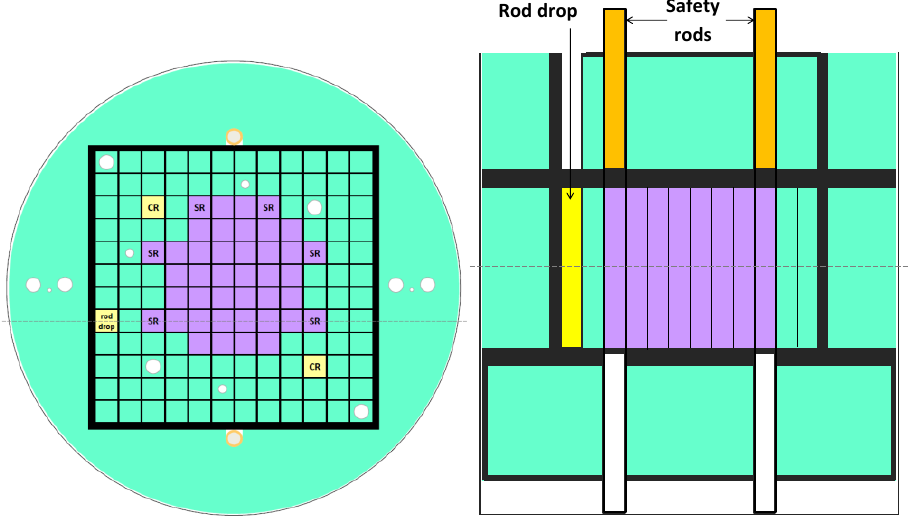
Fig. 2. Left: radial cut through the VENUS-F reactor configuration discussed in this paper. The cut passes through the core midplane (marked with a dashed line in the right-hand side figure). The assembly pitch is 8 cm, both the core diameter and height are 160 cm. Right: axial cut through the core at the plane passing the rod drop and two safety rods (marked with a dashed line in the left-hand side figure). The depicted situation is after the rod was dropped (i.e. it is fully inserted in the core). Fuel assemblies – violet, B 4 C control rods (CR) and rod drop system – yellow, B 4 C safety rods (SR) - orange, lead reflector – green, experimental channels with fission chambers – white circles, stainless steel casing –